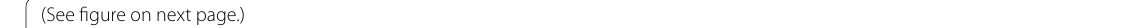
figure on next Fig. 3 A 52-year-old infected doctor with COVID-19 presented with dyspnea and on low flow oxygen support. A , B Axial chest CT cuts (lung window) showing multiple bilateral sub-pleural patchy areas of ground glass attenuation and sub-segmental consolidations in both upper lobes (20%). C , D Axial chest CT cuts (lung window) showing involvement of middle lobe and lingula (5–10%). E , F Axial chest CT cuts (lung window) showing involvement of right and left lower lobes (80% and 75%%) by patchy sub-segmental consolidative areas, curvilinear band and ground glass pattern, interstitial thickening, reticulo-nodular infiltrates and fibrosis, mild bronchial and vascular dilatation. CT severity score (CTSS) is